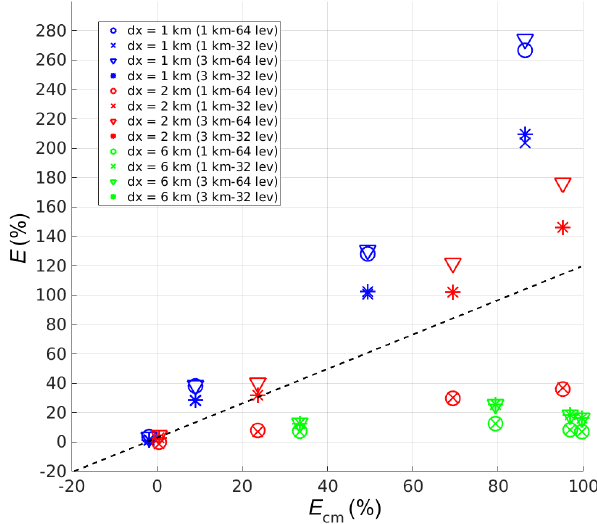
Figure 10. Plot of model errors in percentage, categorised with dif- ferent lengths of heterogeneity (d x ), from the four coarse-grid mod- els ( E ) against the corresponding errors from the complete-mixing model ( E cm ) for the simulations with heterogeneous